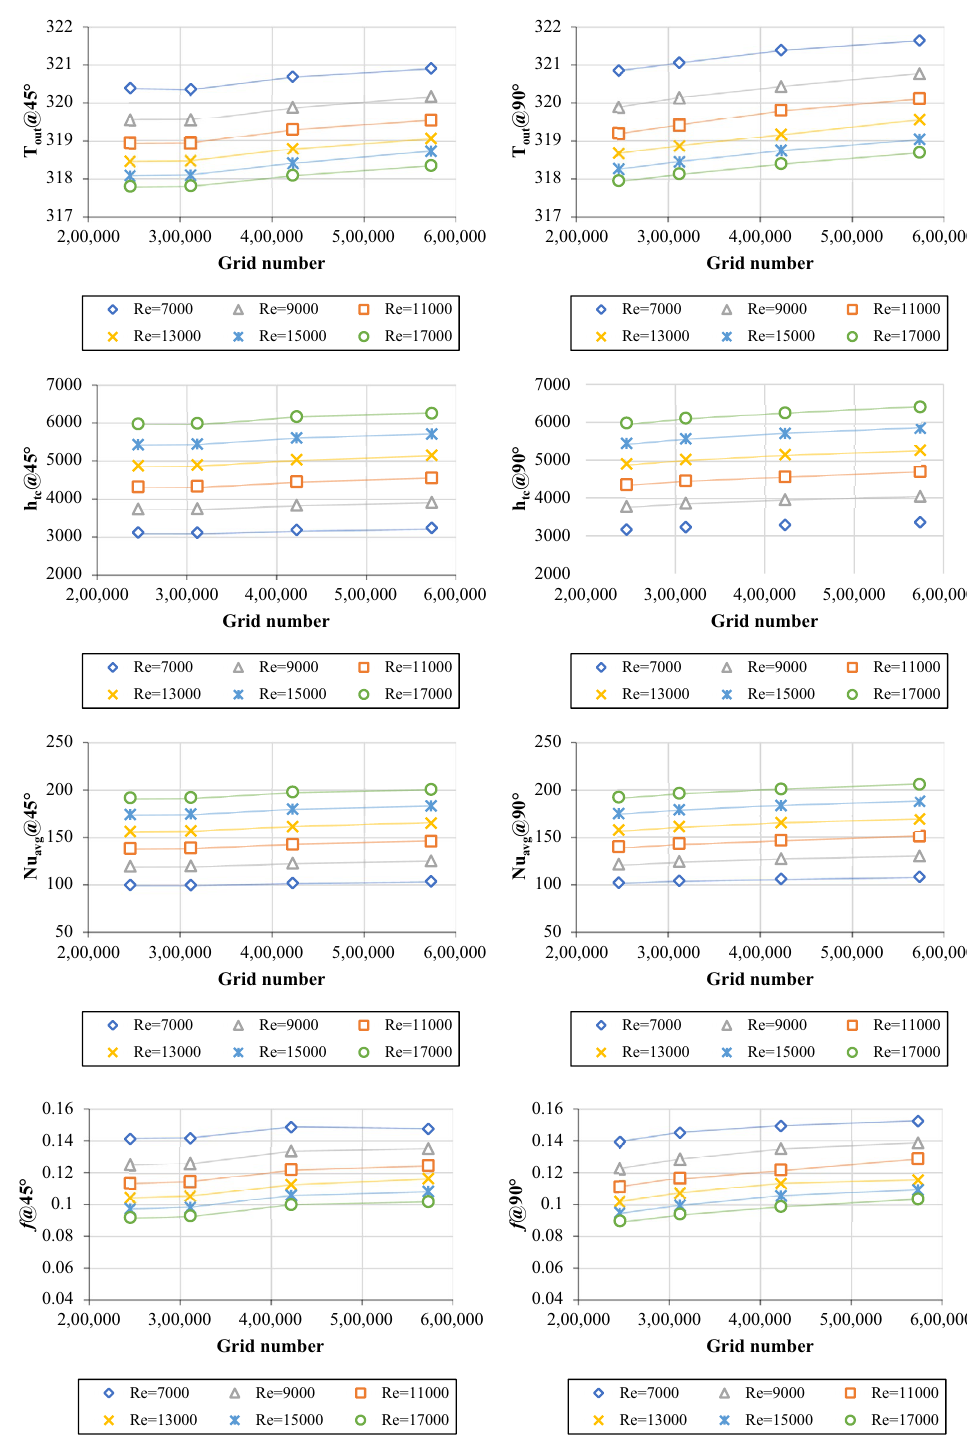
Figure 2. Grid independence tests for heat transfer and pressure drop properties using 45° and 90° twisted pipes for